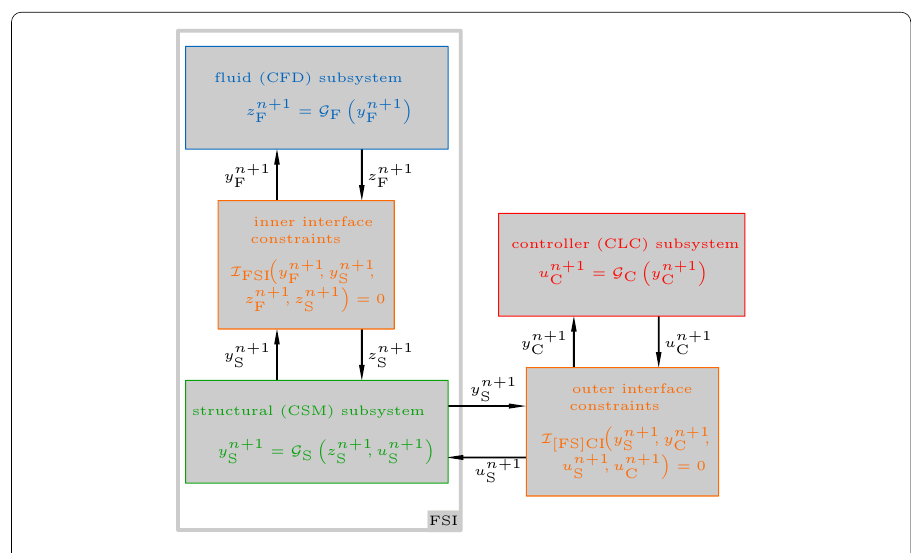
Fig. 3 Block diagram for [FS]CI